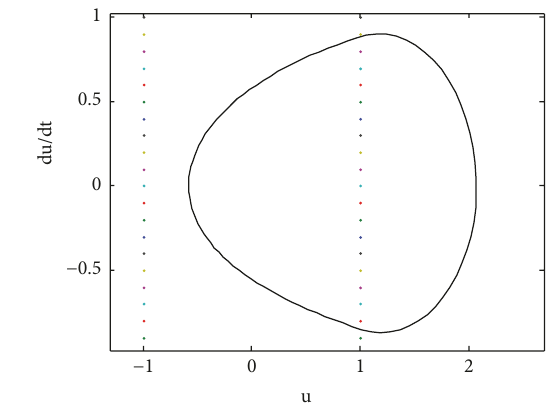
Figure 11: Single-sided impact.